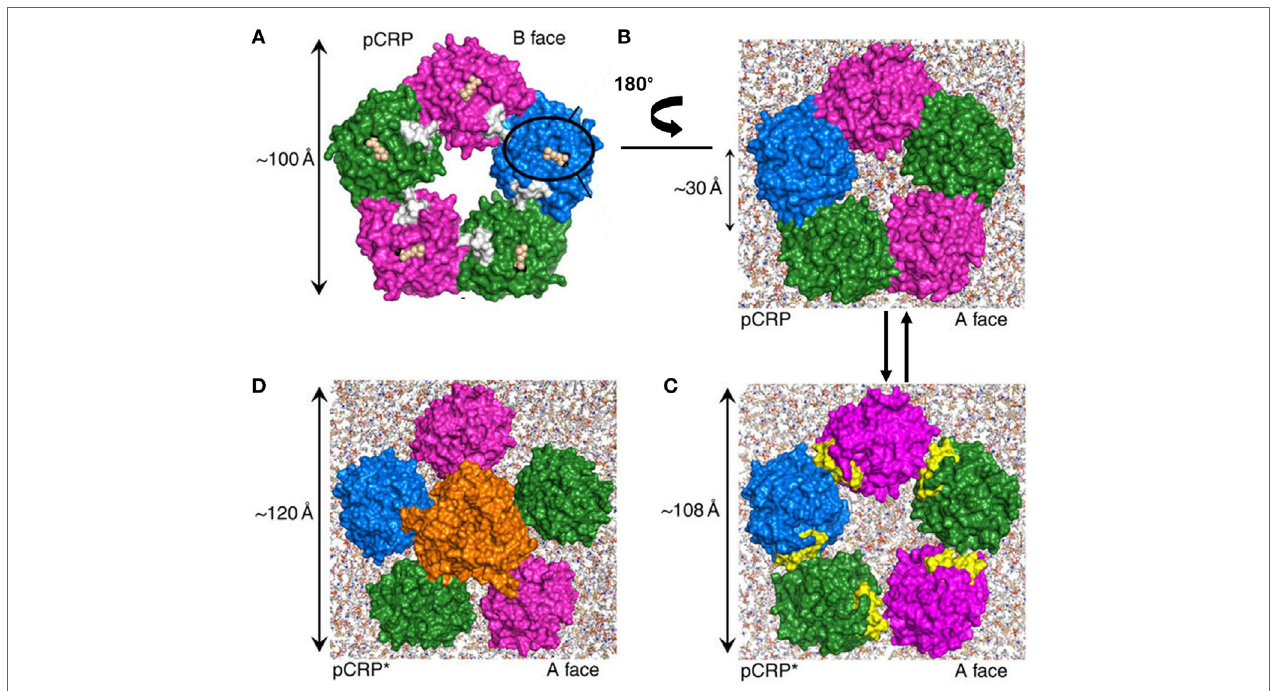
FiGURe 1 | Proposed model of the conversion from the strained to the relaxed conformations of pentameric C-reactive protein (CRP). (A) Solid surface representation of the crystal structure of human CRP in its “strained” conformation (pCRP) bound to phosphocholine (PCh) (PDB entry 1B09) (54). The view shown is from the membrane binding “B face” of pCRP. The individual subunits are represented color-coded, with PCh (cream spheres) and Ca 2 + ions (black spheres) occupying the ligand binding site on each subunit. (B) Modeled interaction of pCRP with a phospholipid bilayer. View is from “above,” looking down onto the pCRP “A face.” Each pCRP subunit can independently bind to a PCh head group of the bilayer. Exposure to lysoPCh triggers reversible conversion of pCRP to pCRP*. (C) Pentameric pCRP*, same view as in (B) . As the individual CRP subunits move apart, a neoepitope (colored yellow) is exposed. (D) The globular head of C1q inserts itself into the inner annular void of pCRP* forcing the subunits further apart [adapted from Braig et al.